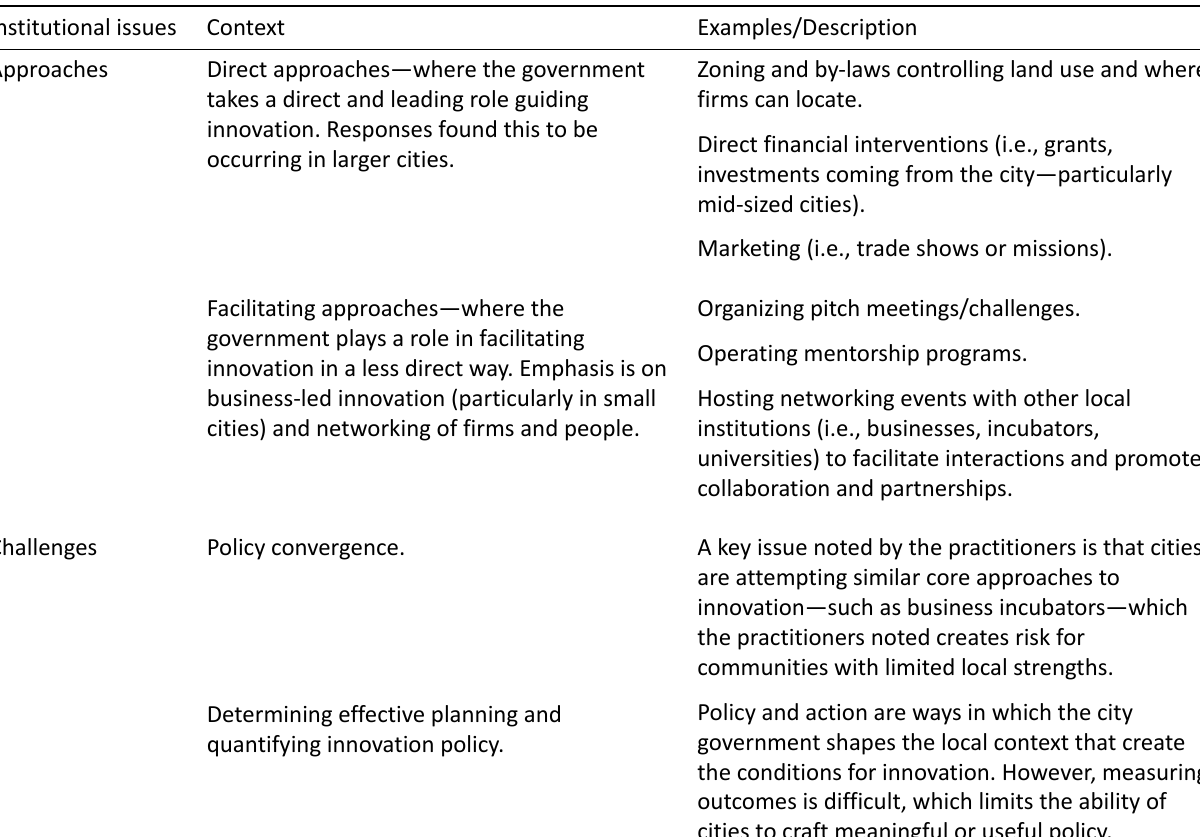
Table 4. Summary of institutional efforts and